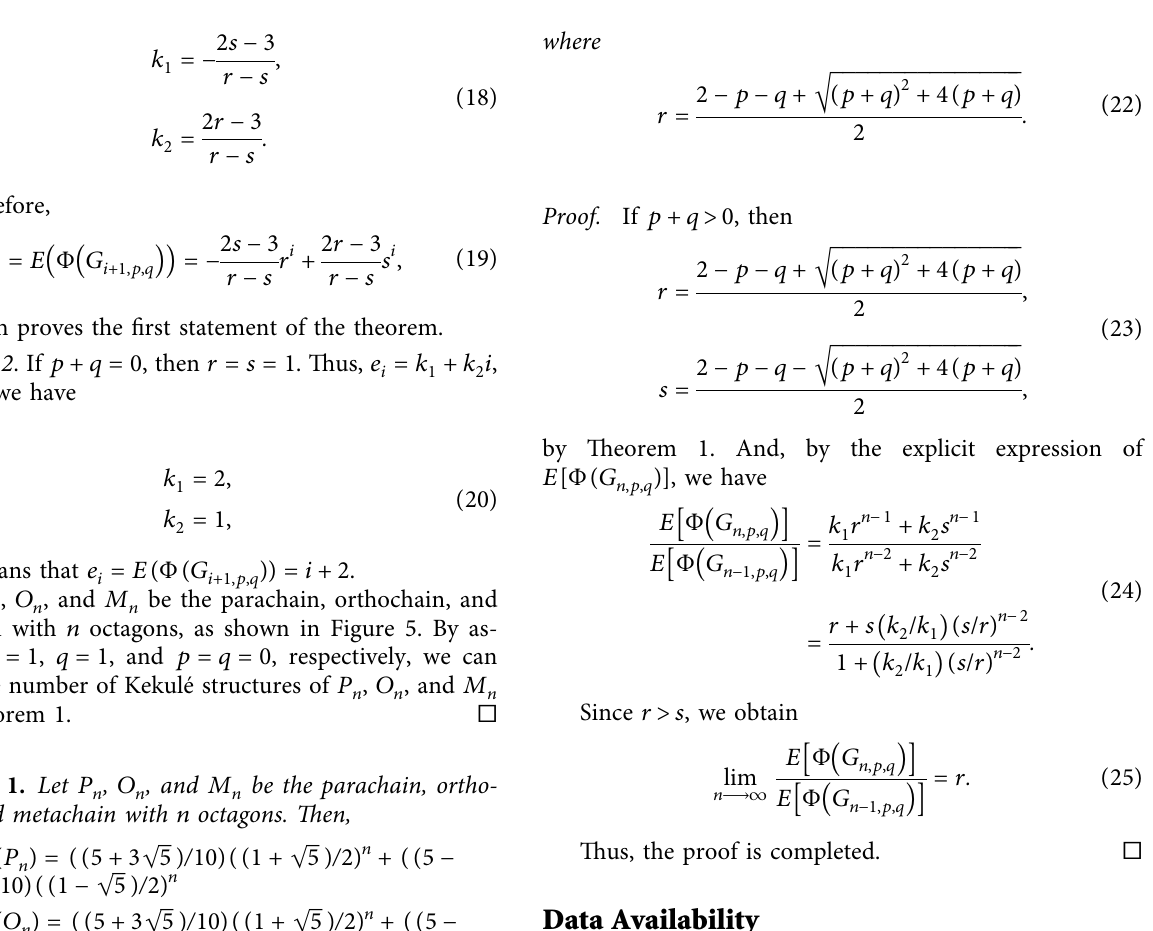
M n octagons. (a) P n with